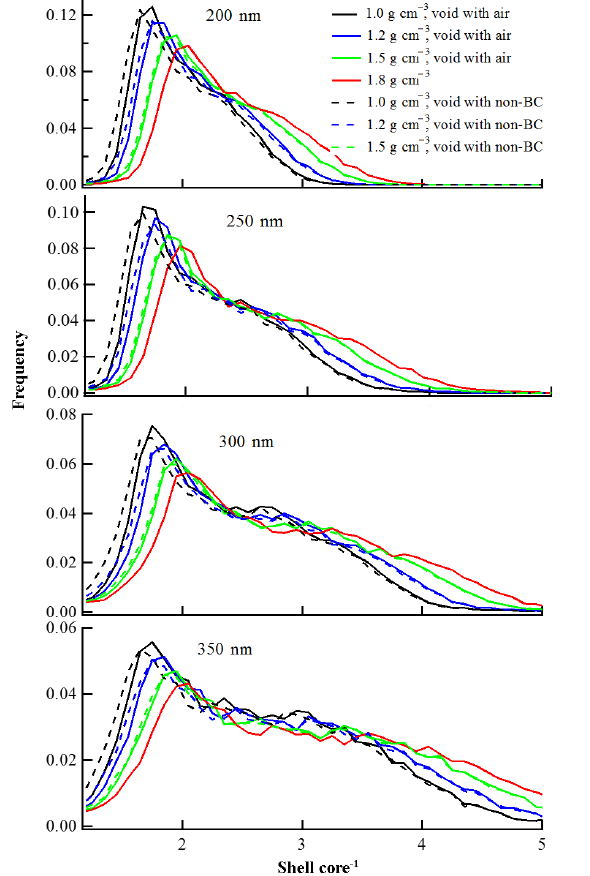
Figure 5. The shell / core ratios ( D p /D c ) of size-resolved ambient In-BC particles with different core densities and void